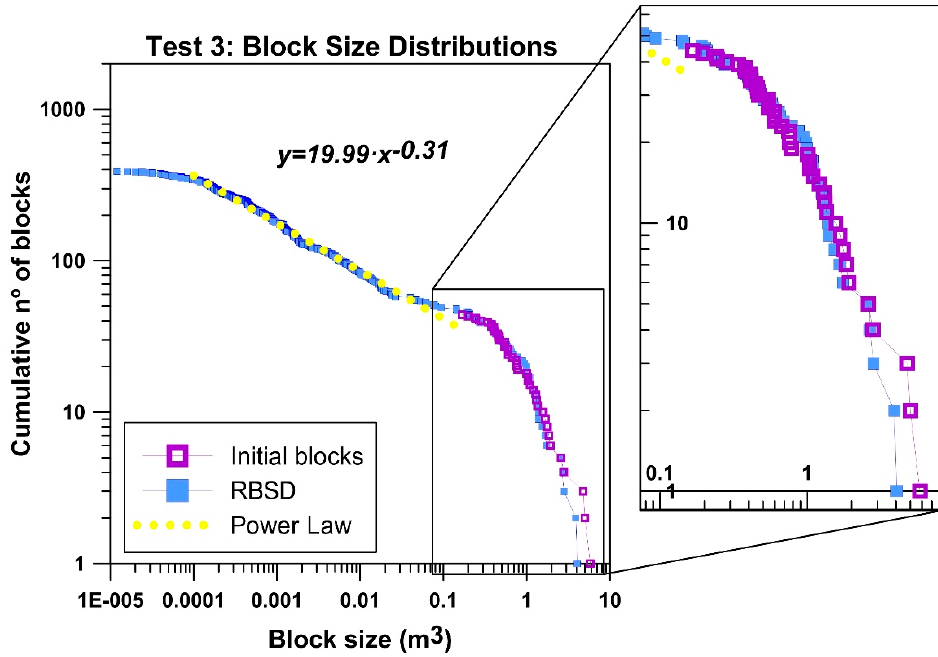
Figure 13. Initial block size distribution (purple) and Rockfall Block Size Distribution (RBSD, all the fragments measured together) obtained in test 3.